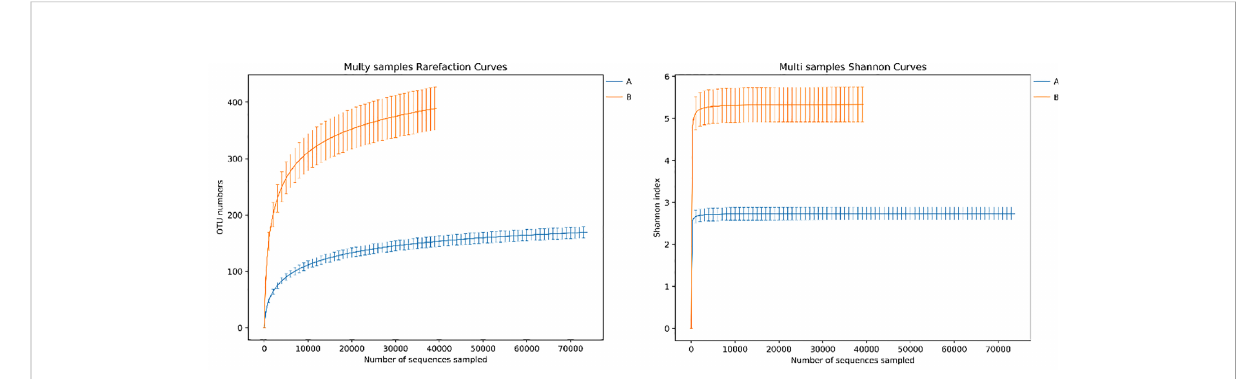
FIGURE 4 Rarefaction curve and Shannon index curve between samples of LRTI children with/without hematological malignancies. Curve A re fl ects BALF samples of LRTI children with hematological malignancies; Curve B re fl ects BALF samples of LRTI children without hematological